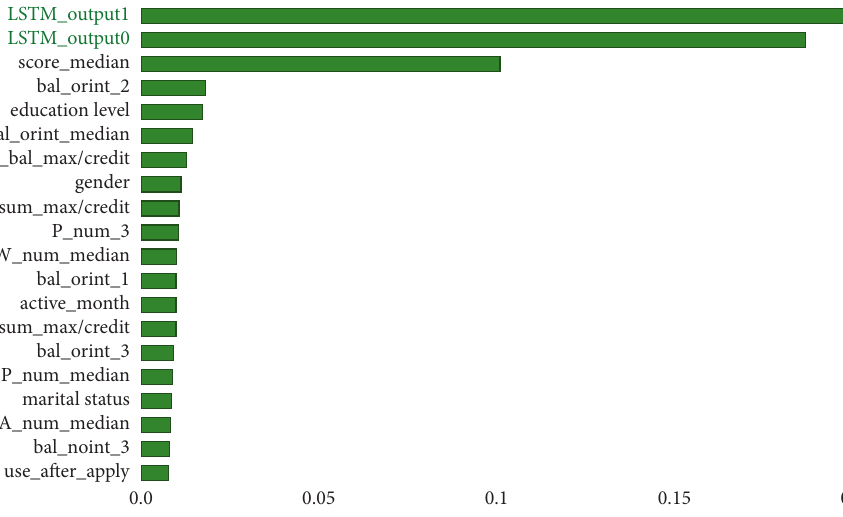
Figure 7: Feature importance index ranking of the XGBoost-LSTM